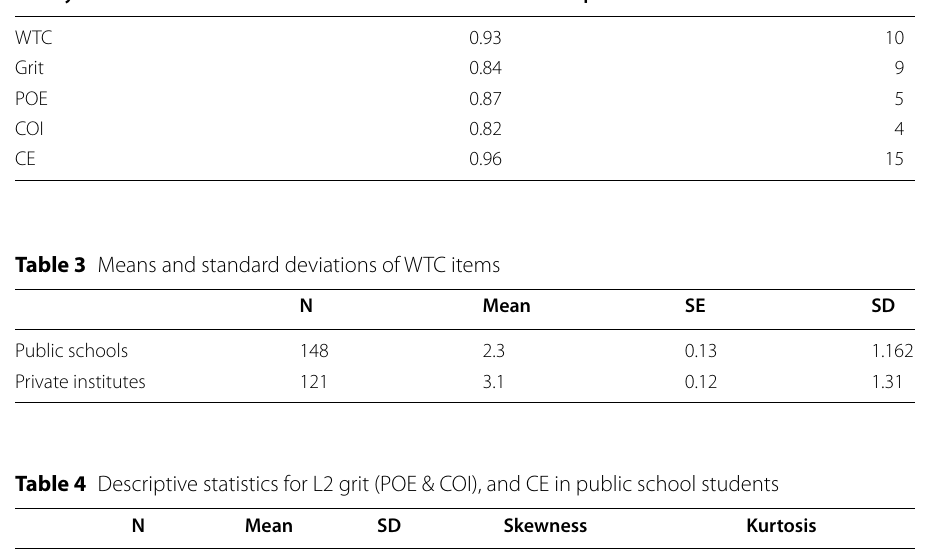
Table 2 The reliability statistics for the three questionnaires of the survey Survey sections